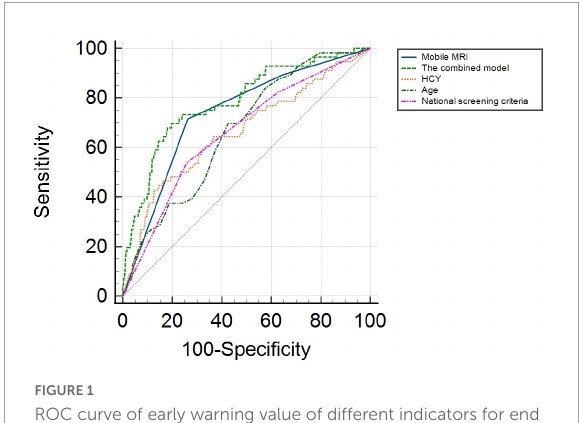
FIGURE1 ROC curve of early warning value of different indicators for end